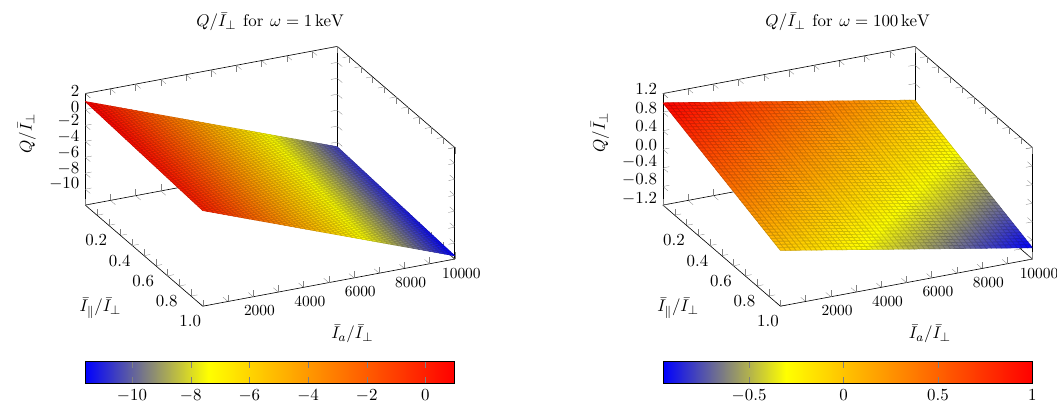
Figure 3 . (Normalized) Stokes parameter Q= (cid:22) I ? at in(cid:12)nity for the benchmark point m a = 10 (cid:0) 8 keV, g = 5 10 (cid:0) 17 keV (cid:0) 1 , r 0 = 10 km, B 0 = 20 (cid:2) surface. The left panel corresponds to ALP energy ! = 1 keV ( P a ! (cid:13) panel corresponds to ! = 100 keV ( P a ! (cid:13)